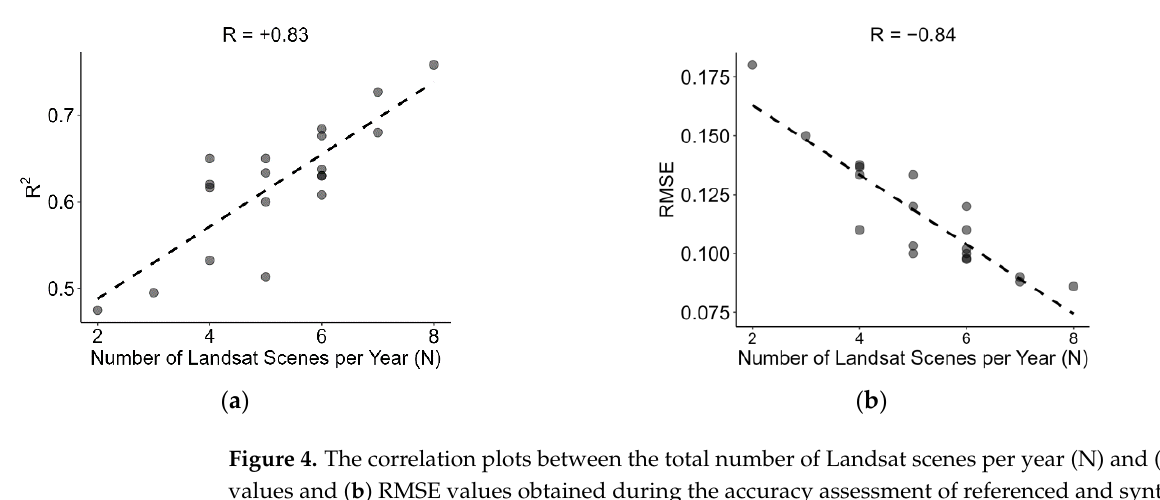
Figure 4. The correlation plots between the total number of Landsat scenes per year (N) and ( a ) R 2 values and ( b ) RMSE values obtained during the accuracy assessment of referenced and synthetic NDVI products from 2001 to 2019. The correlation coefficient refers to R (see Equation (5)).